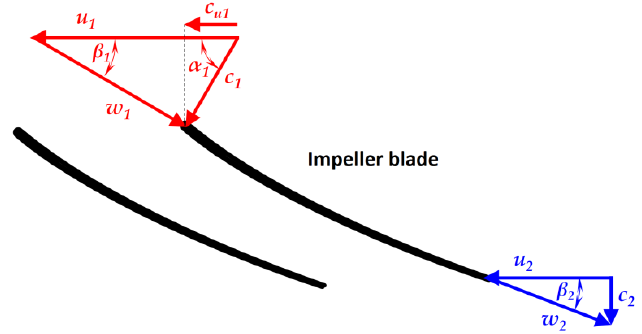
Figure 1. Velocity triangles at the inlet and outlet of the Francis impeller blade.